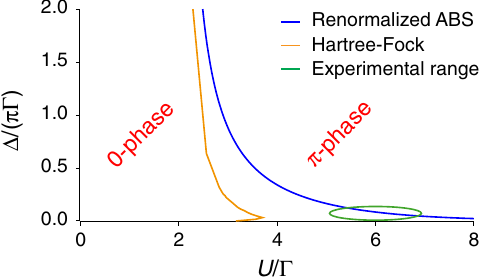
FIG. 7. Theoretical phase diagram for the 0 - (cid:1) transition at the particle-hole symmetry. We compare the renormalized-ABS theory (which includes Kondo correlations) and the static Hartree-Fock theory. Computations for the large-bandwidth limit of the superconducting Anderson model, Eq. (A1), and the experimental range of the operating region of Figs. 5 and 6, are added for clarity. This comparison shows the key role of Kondo screening in allowing the existence of a 0 - (cid:1) transition at intermediate correlations ( U > (cid:1) (cid:1)